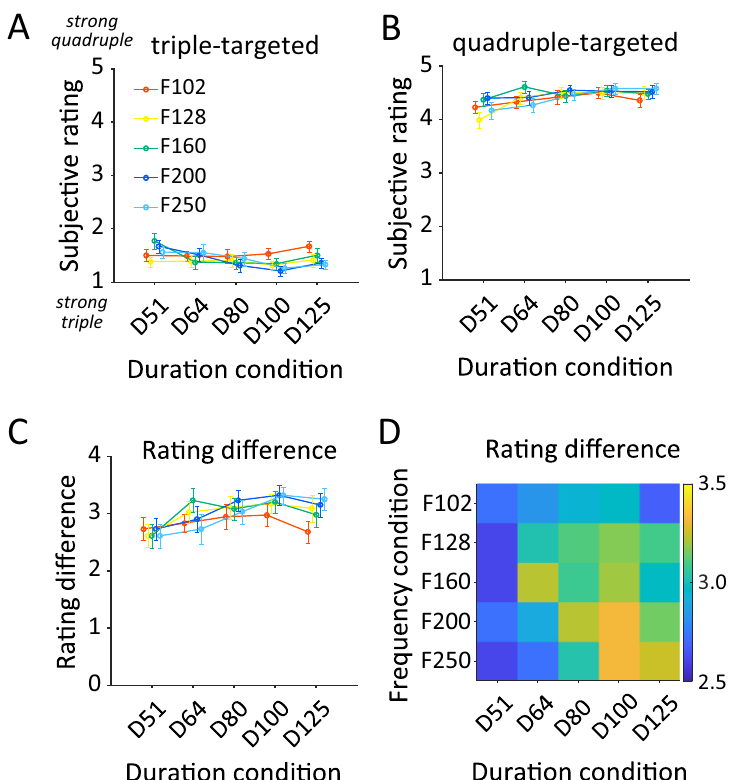
Fig 3. Subjective rating and rating difference for 25 conditions (frequency × duration conditions) in successfully switched participants ( n = 11). A,B. Subjective rating of each condition focused on the acoustic feature which had (A) triple-meter or (B) quadruple-meter regularity. C,D. Rating difference between quadruple-targeted and triple-targeted trials as (C) line plots and (D) a color map. Error bar indicates the standard error across participants.